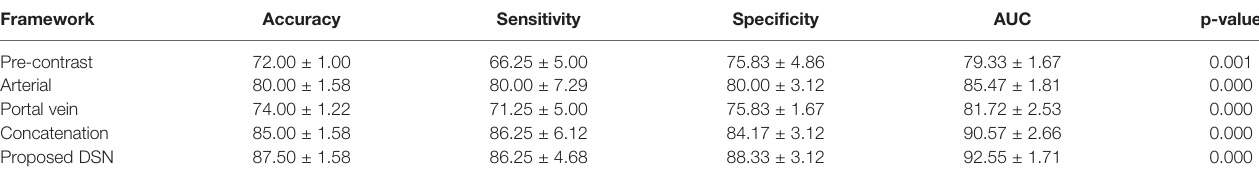
TABLE 4 | Performance of microvascular invasion (MVI) prediction using 3D convolutional neural networks (CNN) in single phases and the combination of multiple phases (%).